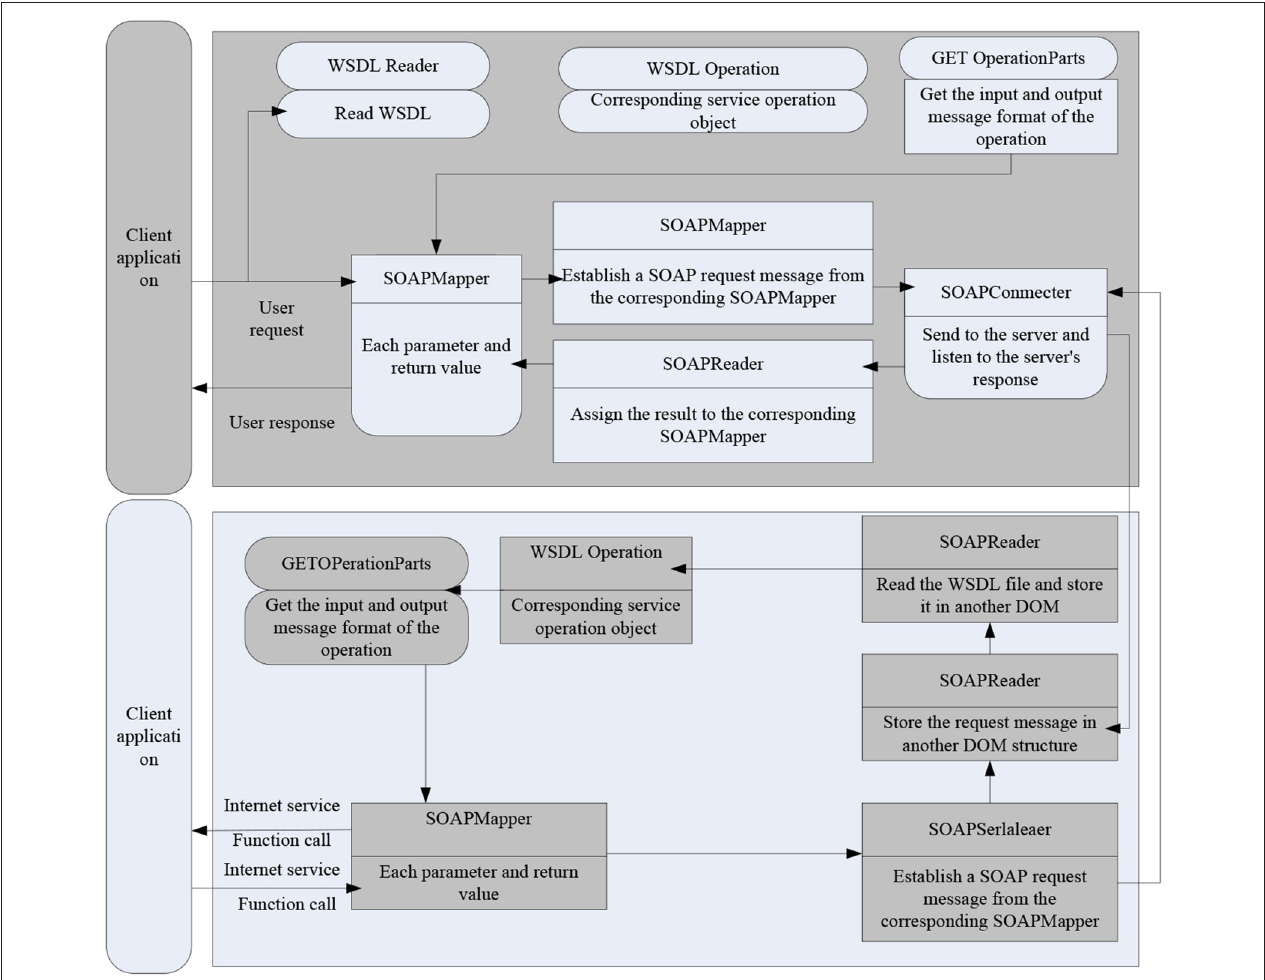
FIGURE 1 | B/S + SOAP